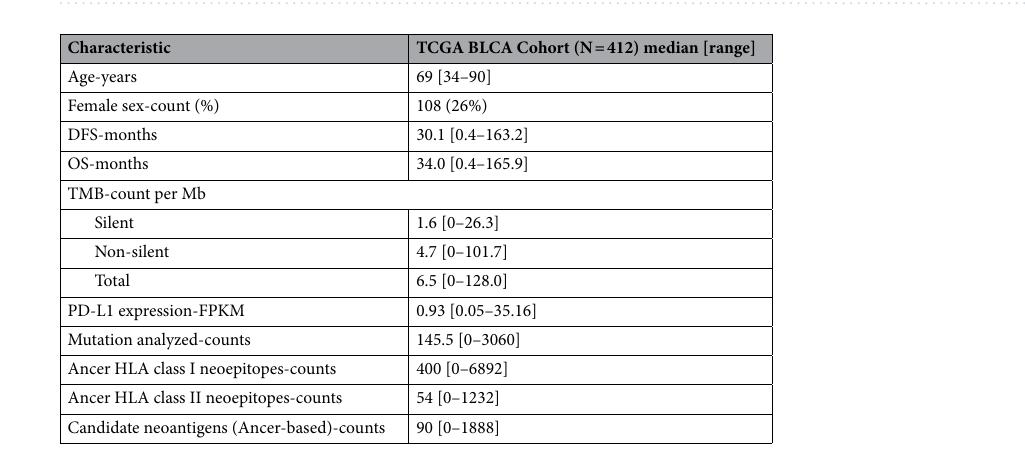
Table 1. Characteristics of the TCGA BLCA